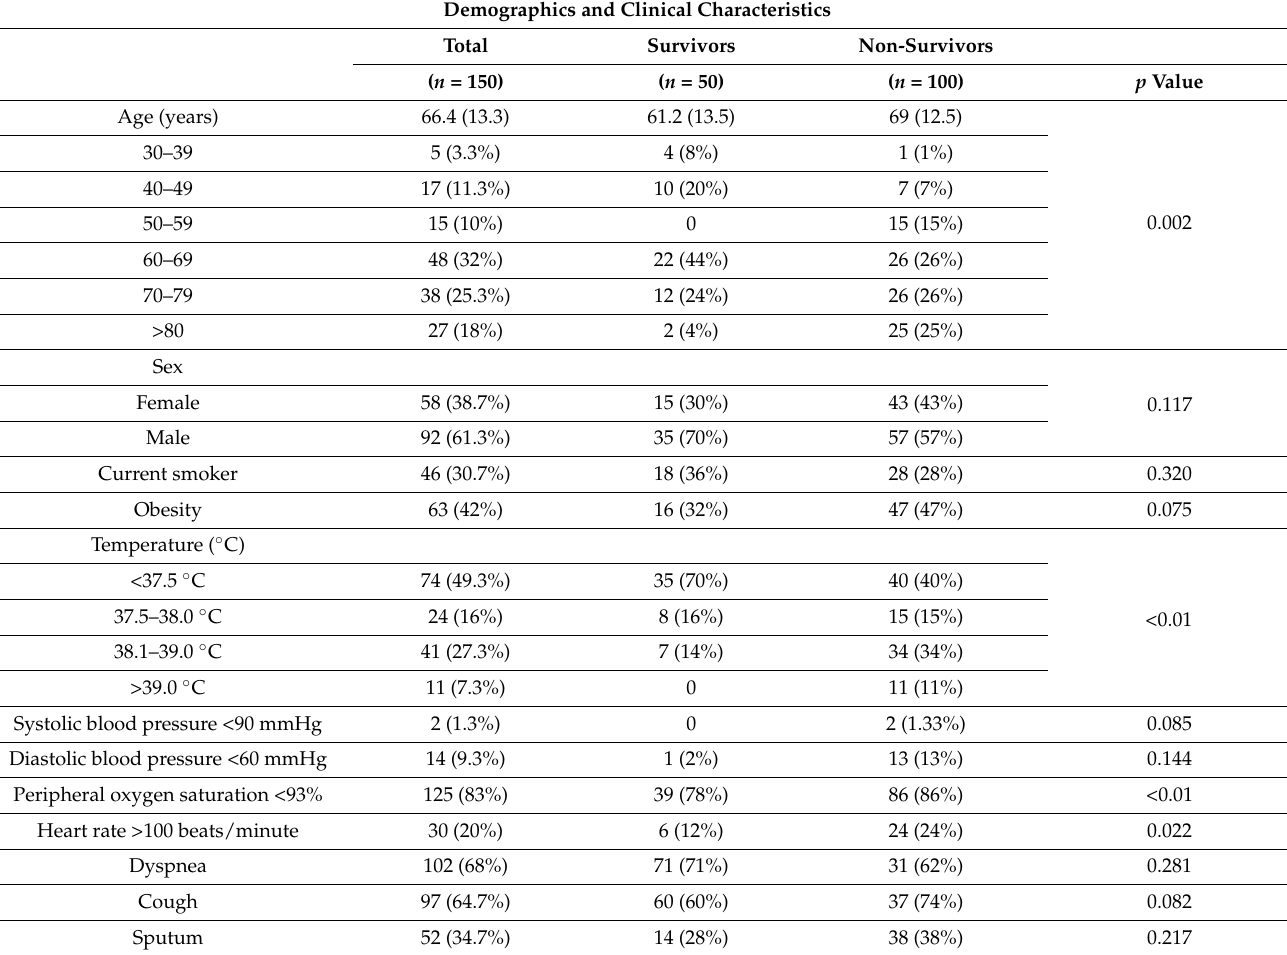
Table 1. Baseline